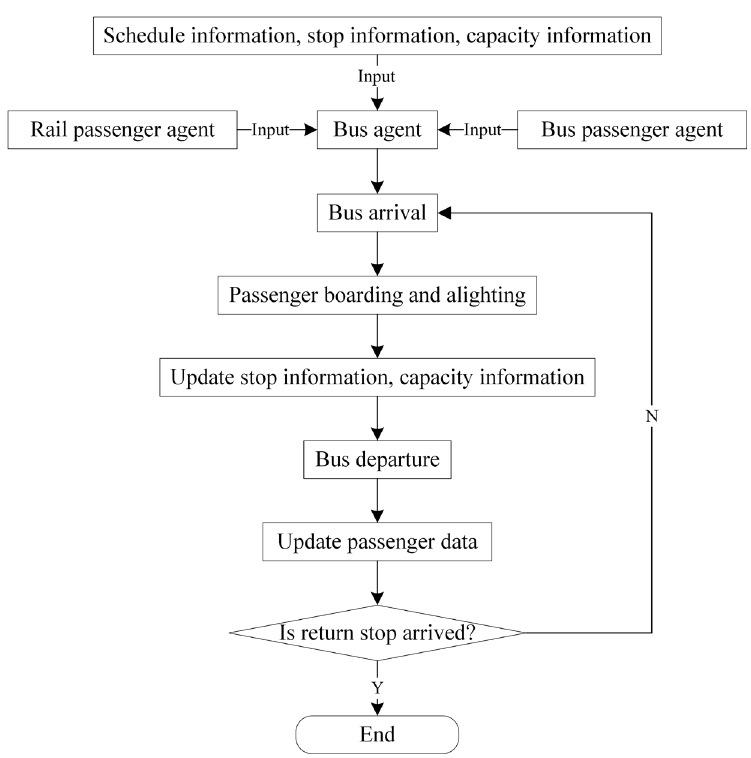
Figure 7. The logical flow chart of bus agent operation process simulation.